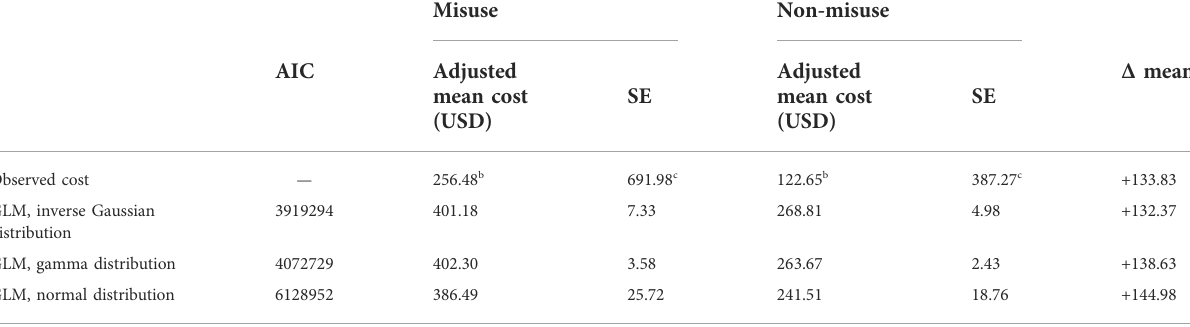
TABLE 2 Observed mean direct medical cost and adjusted mean direct medical cost by modeling a